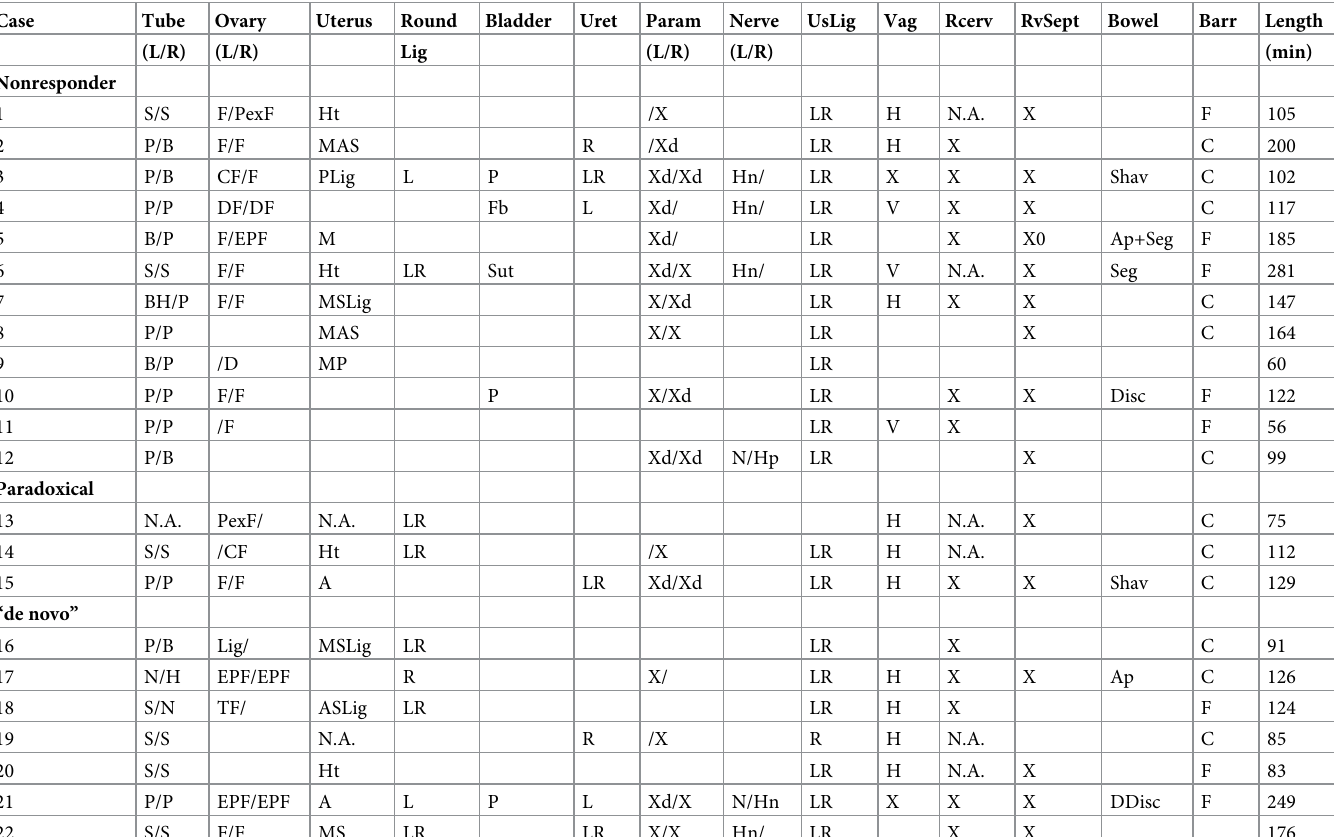
Table 4. Systematic description of the surgical procedures concerning the main sites of endometriosis in the 22 women who were not considered responders for deep dyspareunia.